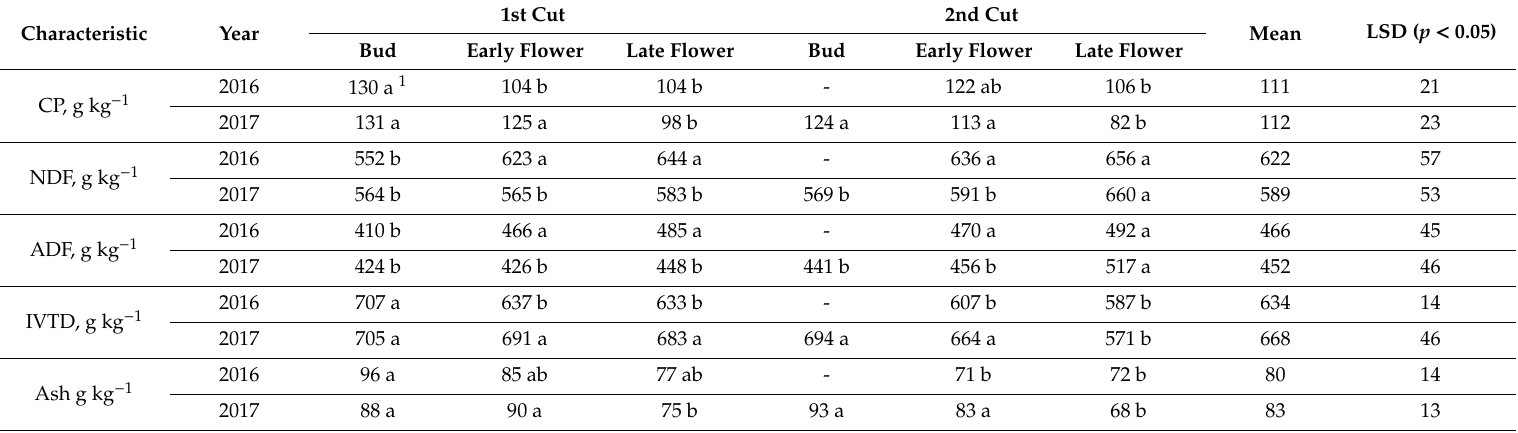
Table 3. Crude protein (CP), neutral detergent fiber (NDF), acid detergent fiber (ADF), in vitro true digestibility (IVTD and ash concentrations in residual stubble after alfalfa was harvested with a modified flail